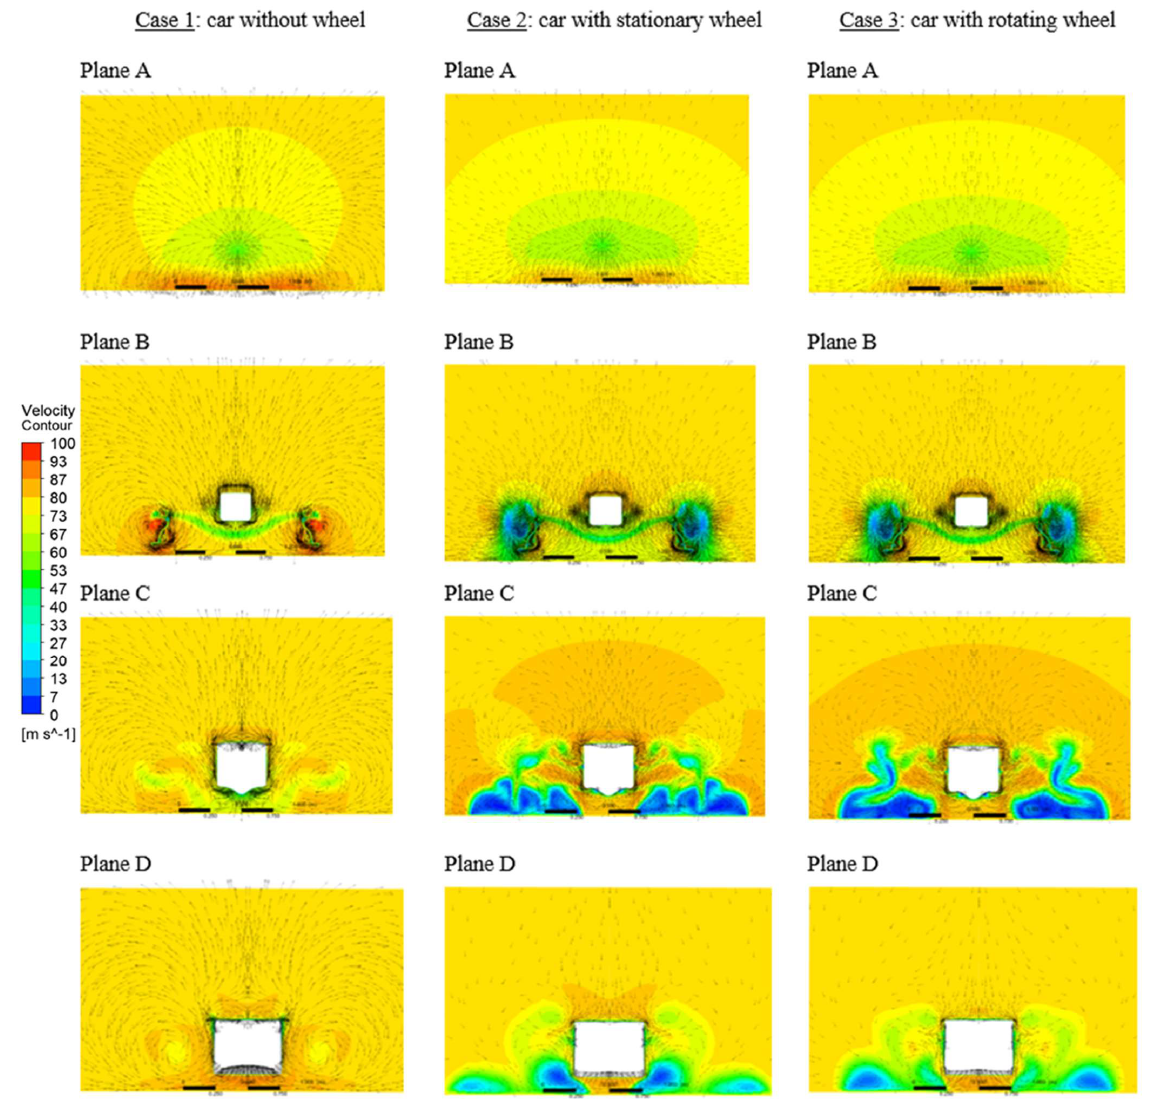
Figure 10. Comparison of the velocity contours on four transversal planes among the three analyzed